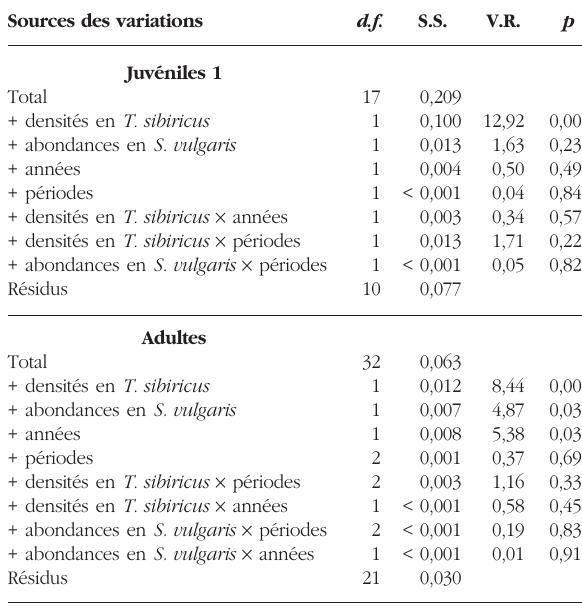
Tableau IV. – Analyse de variance cumulée des modèles de régres- sion linéaire multiple explorant les relations entre l’abondance en C. s. sciurorum en fonction des densités en T. sibiricus (J1 et adultes), de l’abondance en S. vulgaris , de l’année et de la saison, en 2005 et 2006, en Forêt de Sénart.